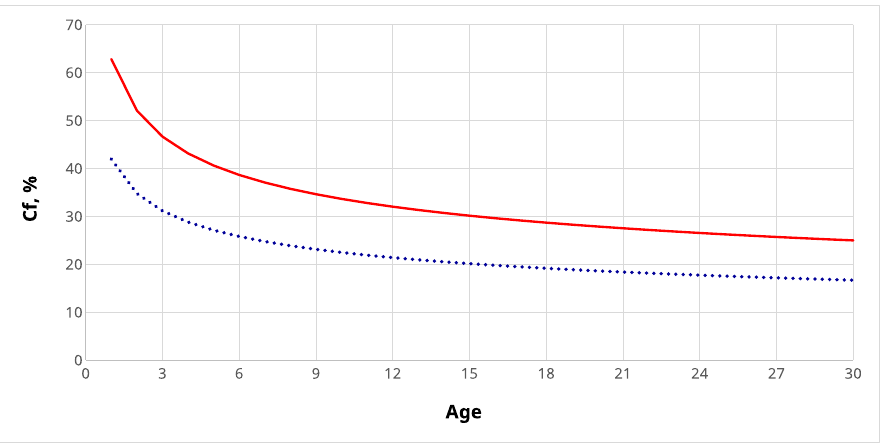
Figure 4. Shape of the combustion factor ( C f ) estimated using the proposal model using age, species, and a given stand, for P. radiata (red) and Eucalyptus spp.